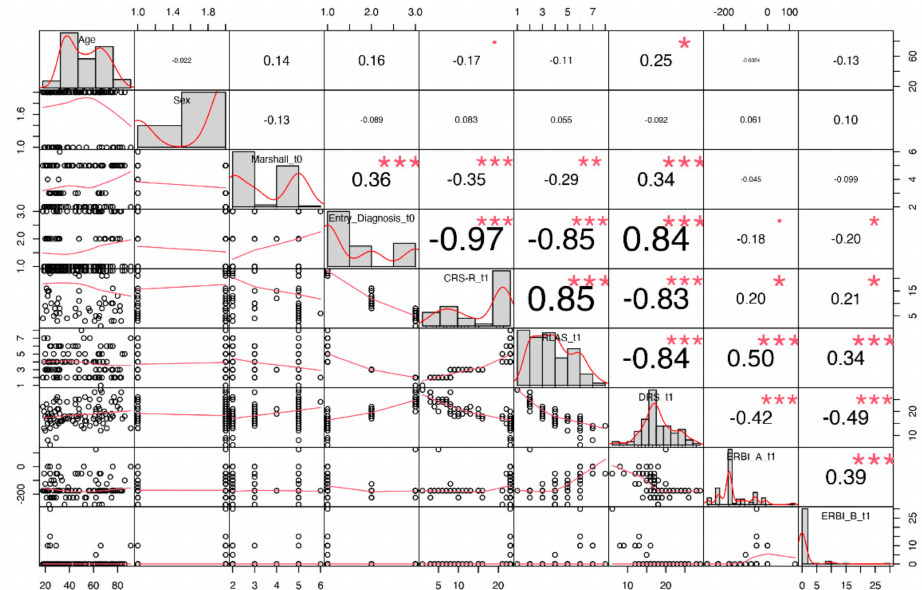
Figure 3. Correlation matrix with paired correlations between each pair of clinical predictors. On the diagonal: distribution of each variable, on the bottom of the diagonal: bivariate scatterplots with a fitted line, on the top of the diagonal: correlation value with significance level. Symbols “***”, “**”, “*”, “.”, indicates respectively p -values <0.001, <0.01, <0.05, <0.1.